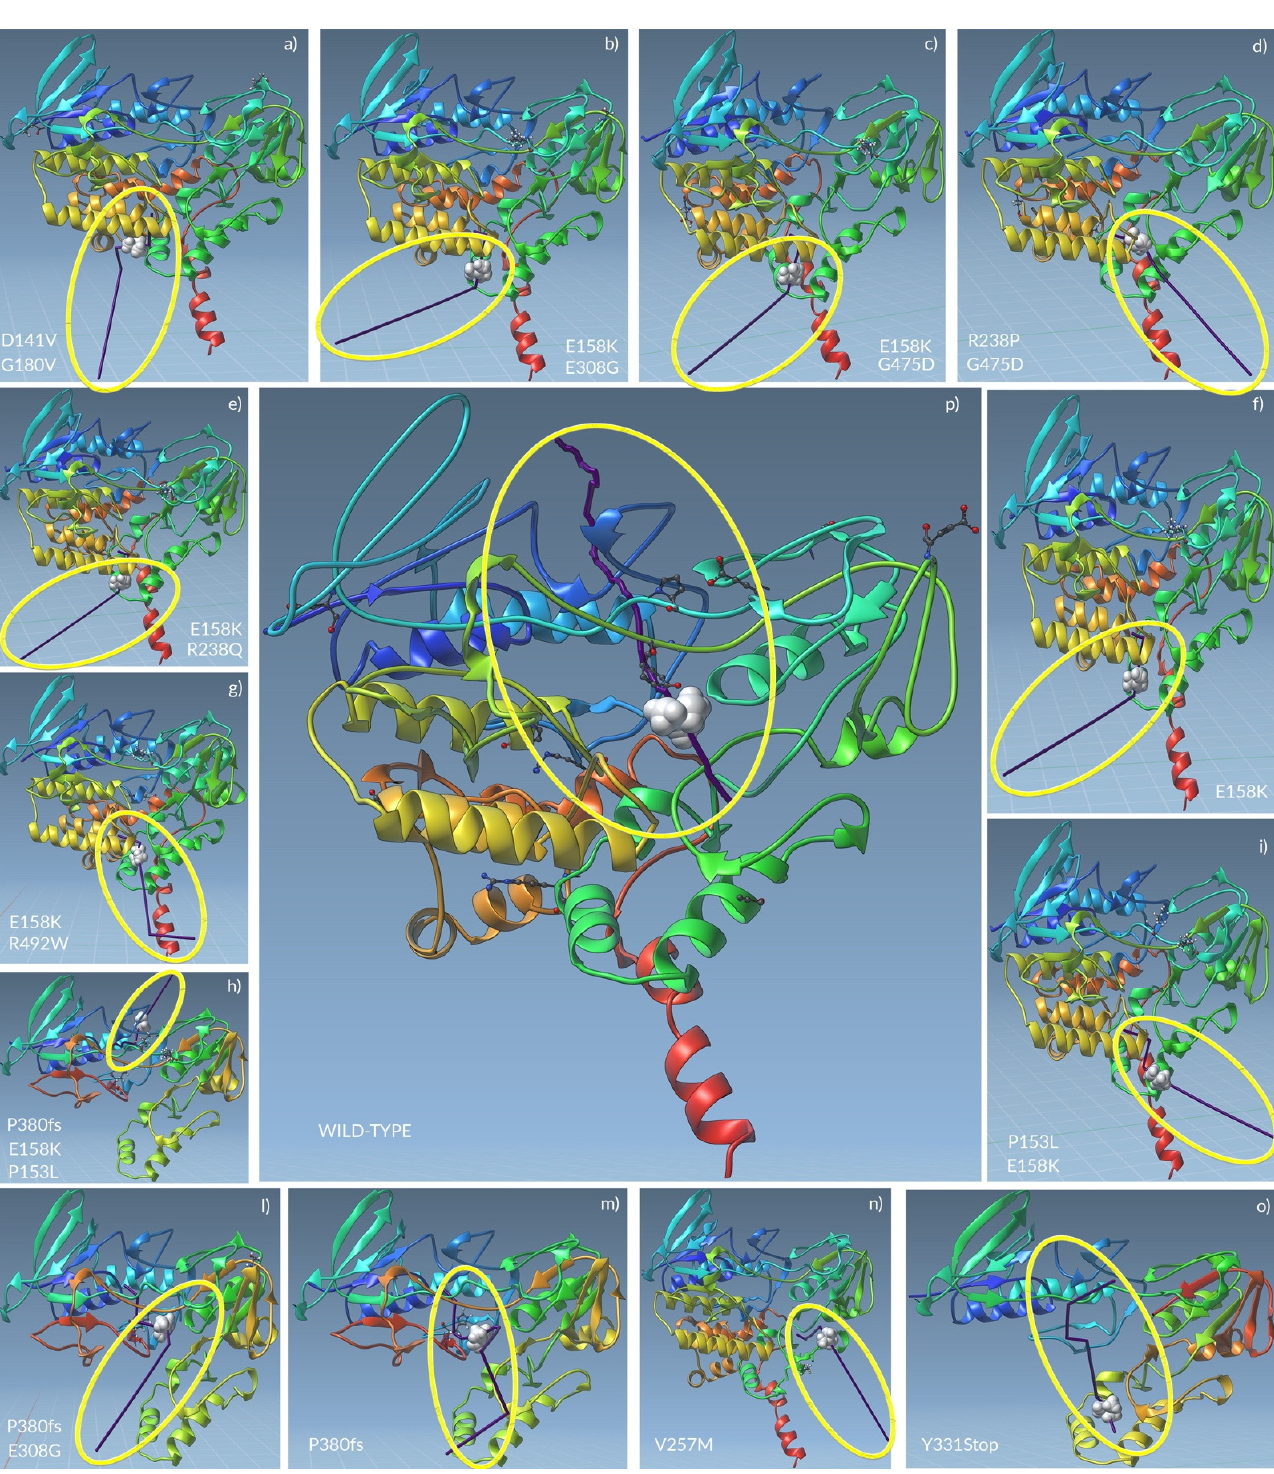
Figure 4. The unbinding pathways analyses showed that FMO3 catalytic activity might not be fully performed. The TMA unbinding pathways through the whole FMO3 mutated proteins ( a – o ) seemed to impair the enzyme functionality when compared to the wild-type one ( p ). The yellow circles indicate the unbinding pathway produced by pathlines (purple line) of TMA (white spheres) through the FMO3 .